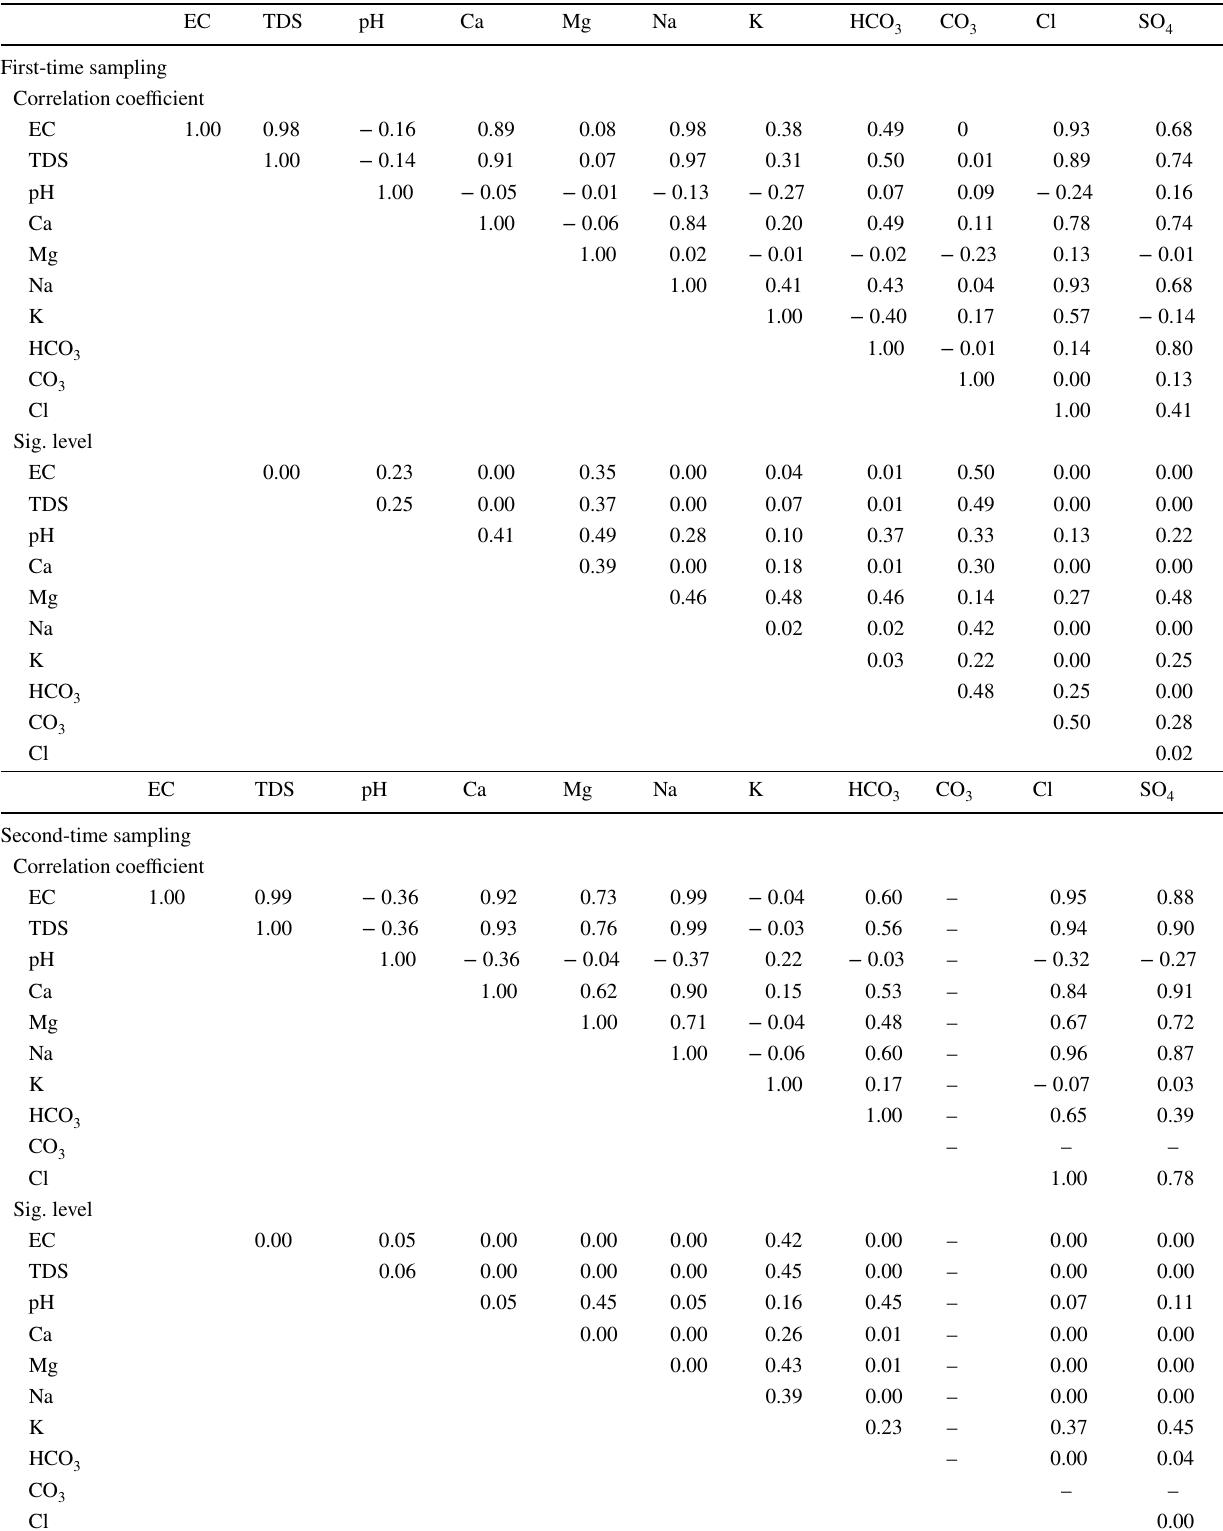
Table 2 Correlation coefficient results for factor analysis for studied parameters in the lake and downstream of the Gotvand-e-Olya Dam EC TDS pH Ca Mg Na K HCO 3 CO 3 Cl SO